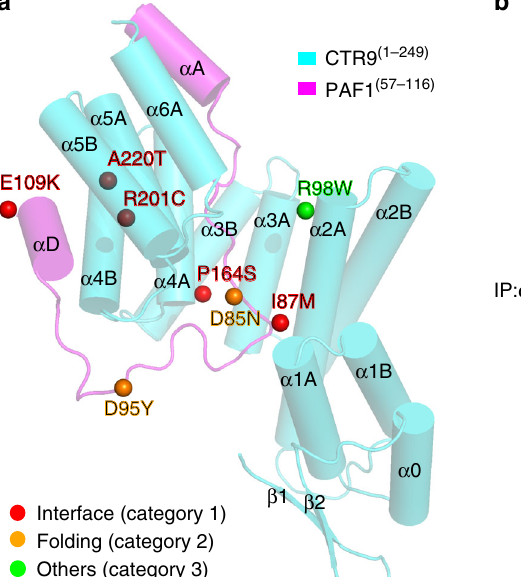
the heterodimer structure (Fig. 2a, e): region I: the N-terminal half-loop of PAF1 (57 – 116) and the concave channel of TPR1 – 5 (Fig. 2b); region II: the C-terminal half-loop of PAF1 (57 – 116) and the side of TPR1 – 5 (Fig. 2c); and Region III: the α D helix at the